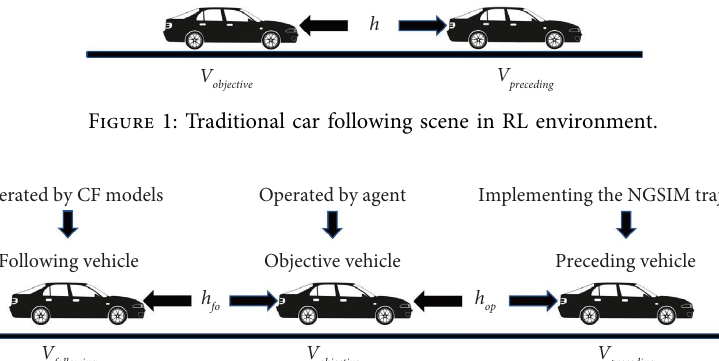
denotes bump-to-bump distance of following vehicle and objective vehicle. of